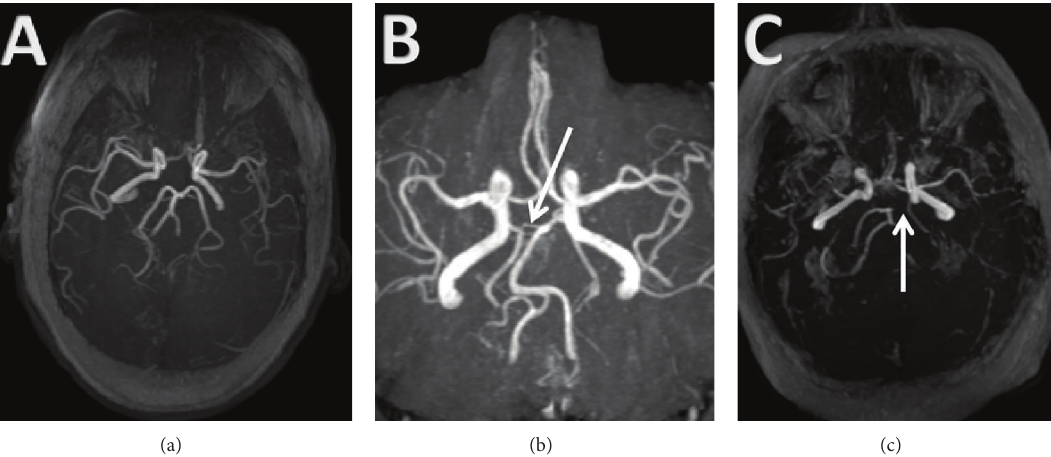
Figure 1: MRI TOF demonstrating a complete fetal PCA (cfPCA) and partial fetal PCA (pfPCA). (a) Typical pattern of PCAs as terminus of basilar artery. (b) Partial fPCA on the right side. The arrow shows an atretic communication between the basilar artery and the posterior communicating artery forming the PCA. (c) Complete fPCA on the left side. The arrow shows lack of communication between the basilar artery and the